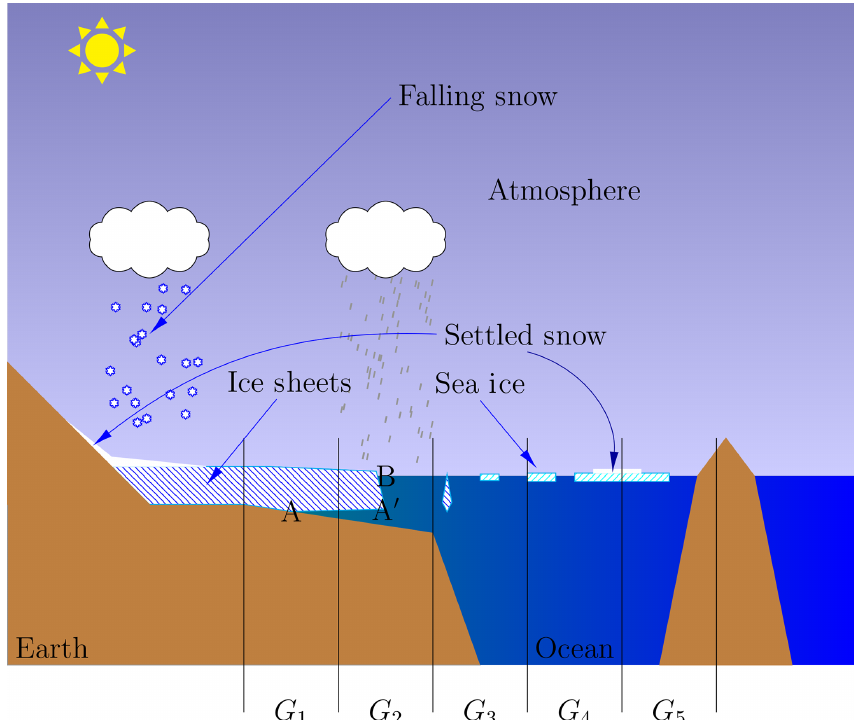
Figure 1. The diagram of a section of floating land ice and some sea ice. The vertical black lines delineate the boundaries of five hypothetical grid boxes. G 1 contains the grounding line of the ice sheet, G 2 contains the ice front and G 3 contains some floating sea ice. G 5 contains a mix of ocean, sea ice and land. As models can now represent sea water extending under the ice sheet ( A to A (cid:48) ) there will be a difference between the grounding line ( A ) and the boundary at the ocean–atmosphere interface ( B ). In CMIP6 diagnostics, the land surface is taken to extend to B so that diagnostics such as the surface radiation balance are treated consistently across the ice sheet